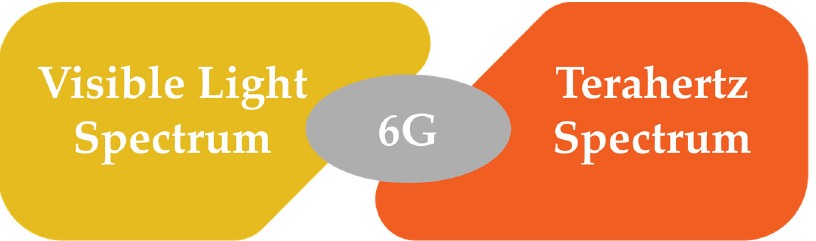
Figure 3. 6G spectrum technologies.